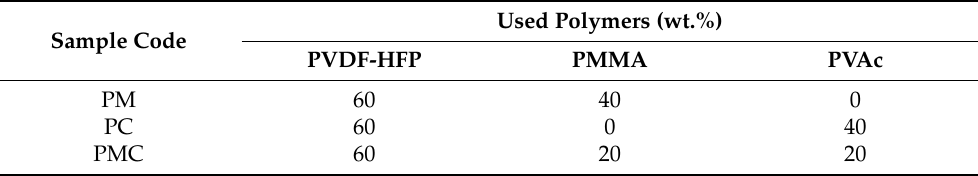
Table 1. Composition of polymers